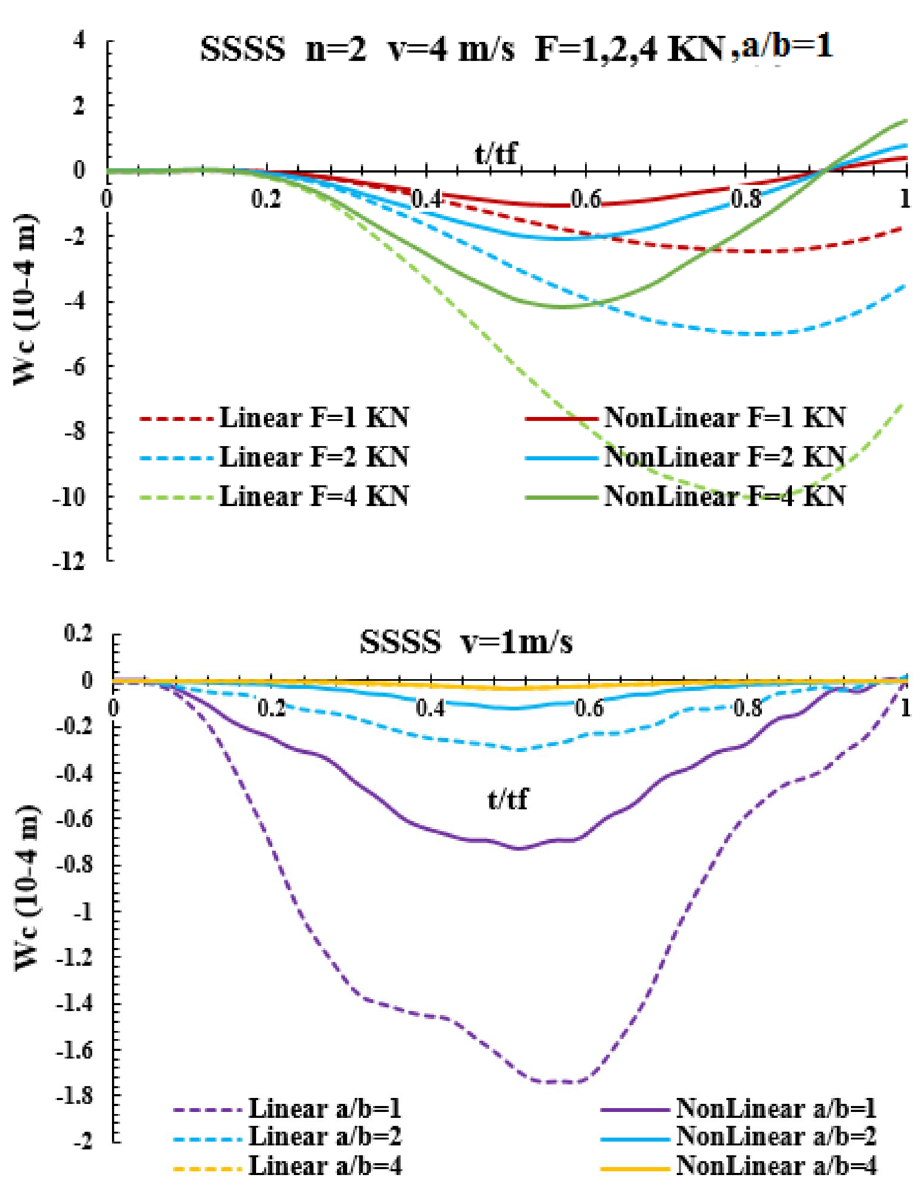
Fig. 15 The effect of magni- tude of moving load on deflec- tion history of center-point of the plate (SSSS boundary condition)